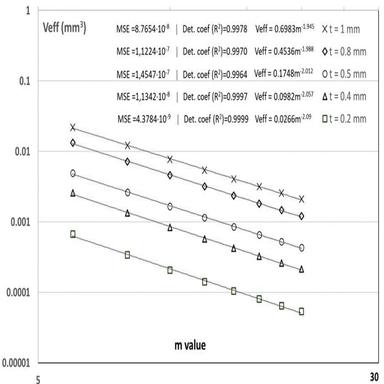
Variation of the effective volume, Veff, calculated by FEM, with Weibull modulus, m, for different specimen thicknesses, t (log-log coordinates).